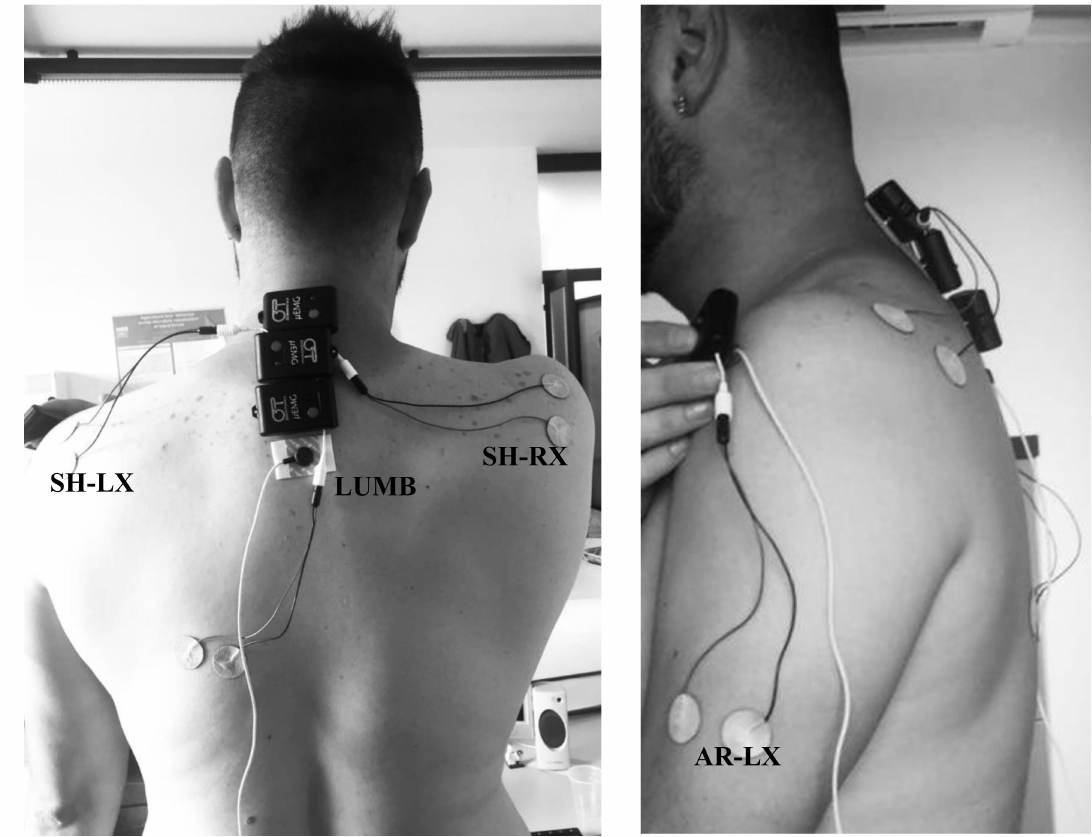
Figure 3. The position of the electrodes for